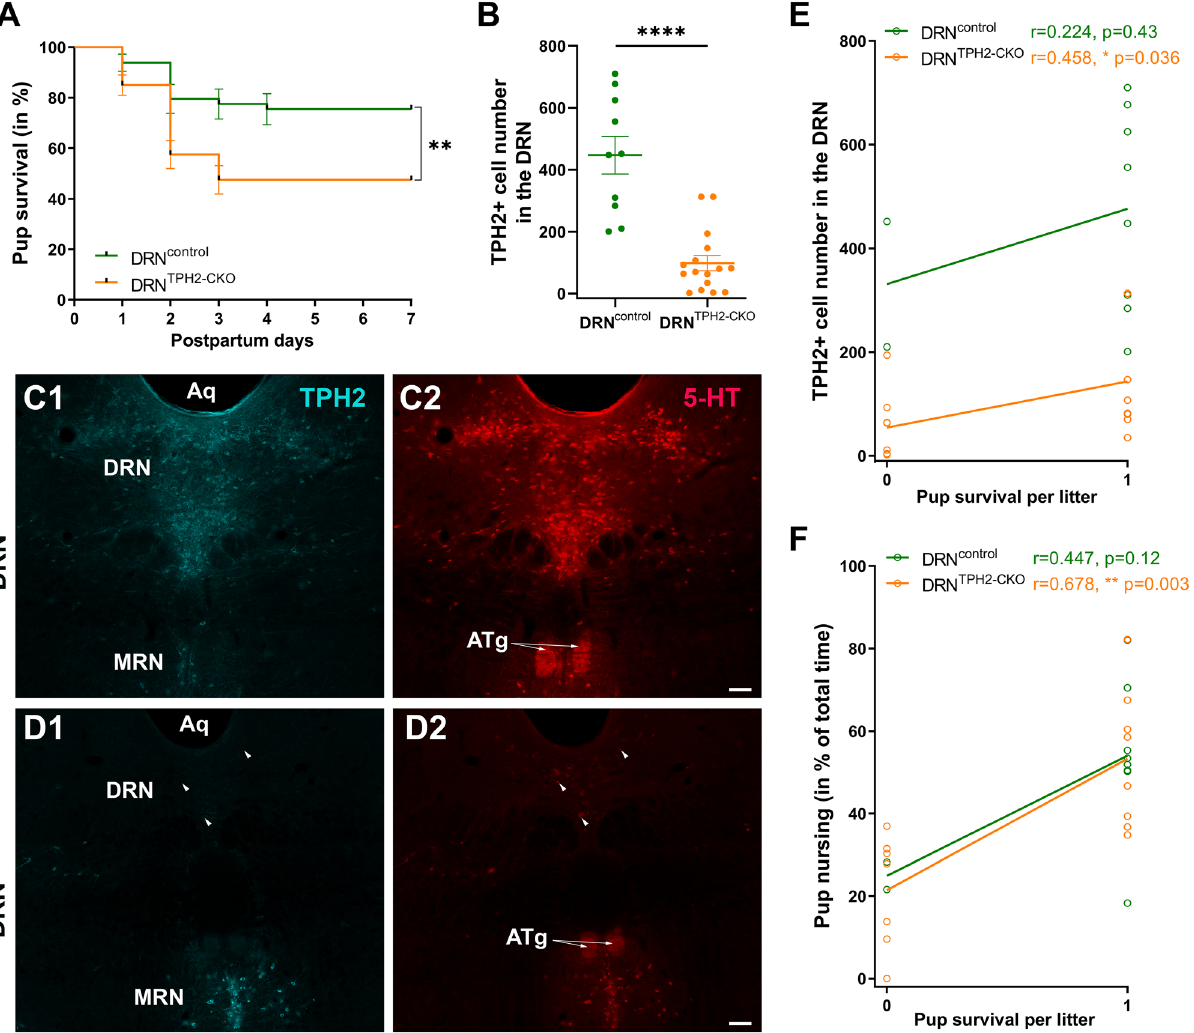
Figure 5. Selective 5-HT depletion from DRN neurons in experienced mothers is sufficient to reduce pup survival and nursing behavior. Primiparous Tph2 flox/flox and their controls (C57BL/6) were injected with AAV9. hSyn.HI.eGFPLCre.WPRE.SV40 in the dorsal raphe nucleus (DRN). Three weeks after surgery, experienced DRN Tph2−CKO and DRN control dams were bred again with WT males. The number of litters analyzed are n = 16 for DRN Tph2−CKO dams and n = 10 for DRN control dams. All litters were culled to 5 pups. ( A ) n = 8/16 DRN Tph2−CKO dams lost their whole litter vs. n = 2/10 DRN control dams, leading to a significant reduction of the pup survival by DRN Tph2−CKO dams compared to the DRN control dams; ** p < 0.01 (mean ± SEM, Log-rank Mantel-Cox test). ( B ) Counting of TPH2 + neurons through 4 rostro-caudal levels encompassing the dorsal/ventral/lateral subdivisions of the DRN. A significant reduction in the number of TPH2 + neurons was found in DRN Tph2−CKO dams compared to DRN control dams; **** p < 0.0001 (mean ± SEM, Mann–Whitney test). ( C,D ) Representative pictures showing a broad expression of TPH2 + and 5-HT + neurons in the DRN of the DRN control mothers ( C1,C2 ), which is nearly absent in the DRN Tph2−CKO mothers ( D1,D2 ). The presence of TPH2 + ( C1–D1 ) and 5-HT + ( C2–D2 ) neurons in the median raphe nucleus (MRN), as well as the dense 5-HT axon innervation in the anterior tegmental nucleus (ATg, white arrows) coming from the MRN, is also observed in both cases ( C2–D2 ), validating the specificity of the DRN targeting. Scale bar = 100 µm (MetaMorph v7.8, Molecular Devices, USA). ( E,F ) The scatter plots (with best-fit regression lines) show a significant correlation of pup survival per litter with the number of TPH2 + cells in the DRN ( E ) and with nursing time ( F ) in the experienced DRN Tph2−CKO group. Pup survival was either fully compromised (0 on the X axis) or ≥ 80% (1 on the X axis) (Kendall’s tau